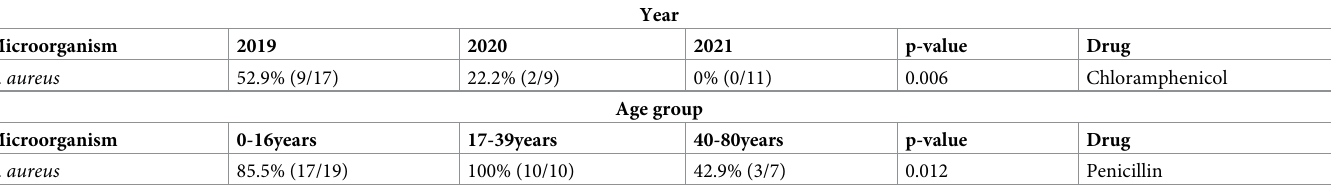
Table 2. The resistant pattern of some IPD bacteria isolates with respect to year of isolation and patient age